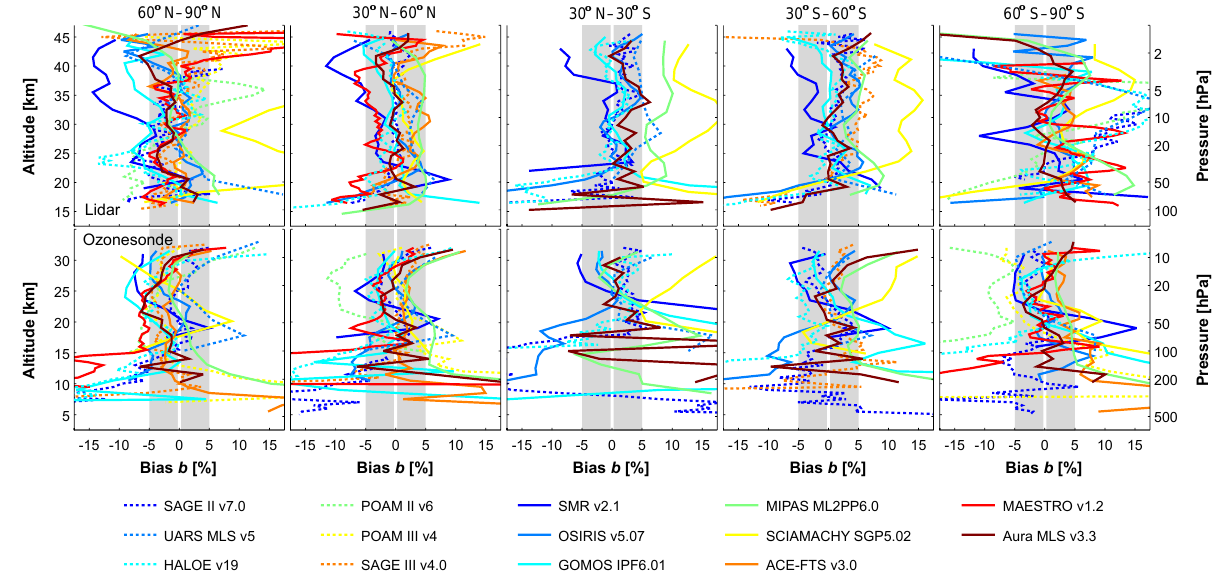
Figure 10. Overview of the bias b of all satellite ozone records relative to the stratospheric ozone lidar (top row) and ozonesonde (bottom) network in five latitude bands (columns). Dashed lines indicate instruments that ceased operations prior to 2006. The analysis is done in the native profile representation of each satellite record. Most satellite records agree within ± 5% with the ground-based data in the middle and upper stratosphere (grey shaded